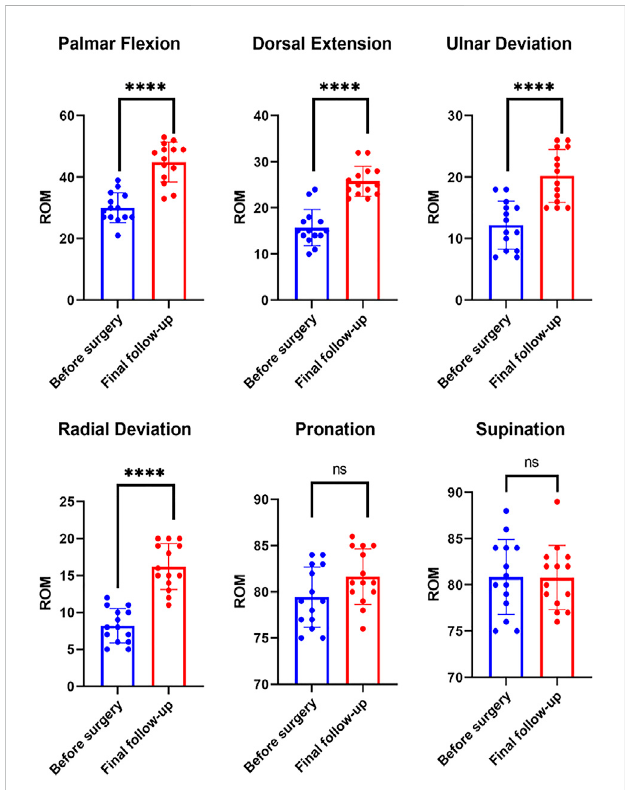
FIGURE 5 Comparison of ROM observed before surgery and at fi nal follow- up. ROM, range of motion.